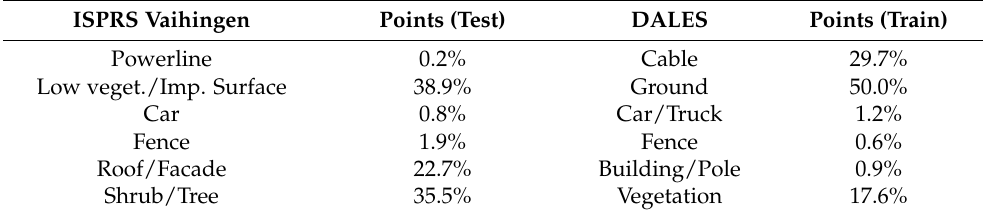
Table 16. Corresponding classes between ISPRS Vaihingen and DALES datasets along with their distributions.